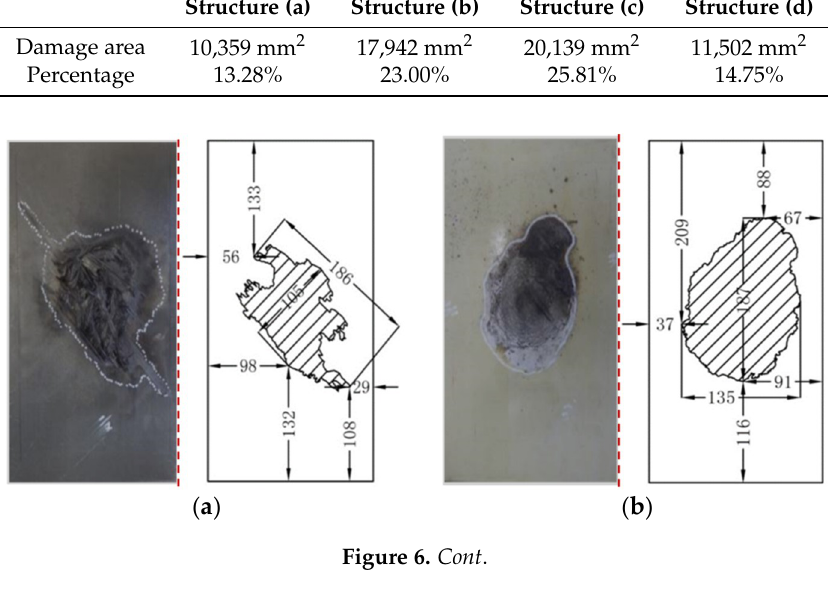
Table 4. Surface damage area of composite-reinforced panels.